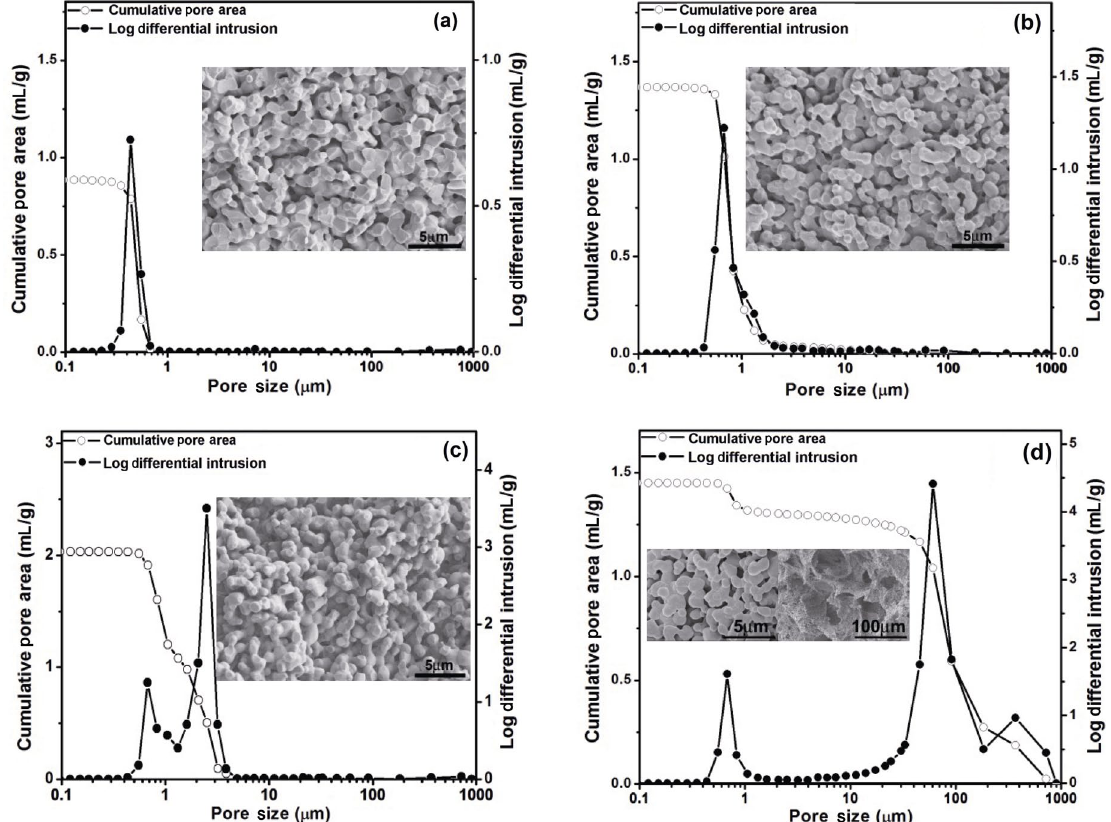
Fig. 3 MIP and SEM images (inserted in MIP) of the through-porous HA ceramics prepared from the green bodies with (a) 55 wt%, (b) 48 wt%, (c) 38 wt%, and (d) 23 wt%